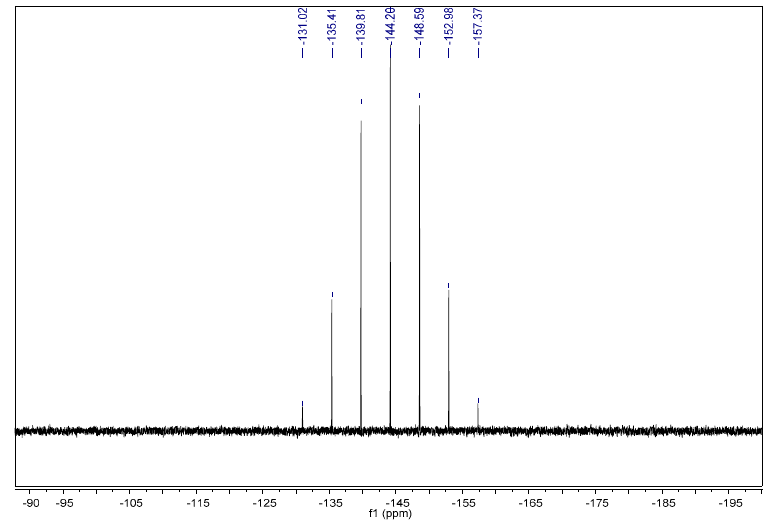
Figure 3. 31 P NMR spectrum of compound 24 .